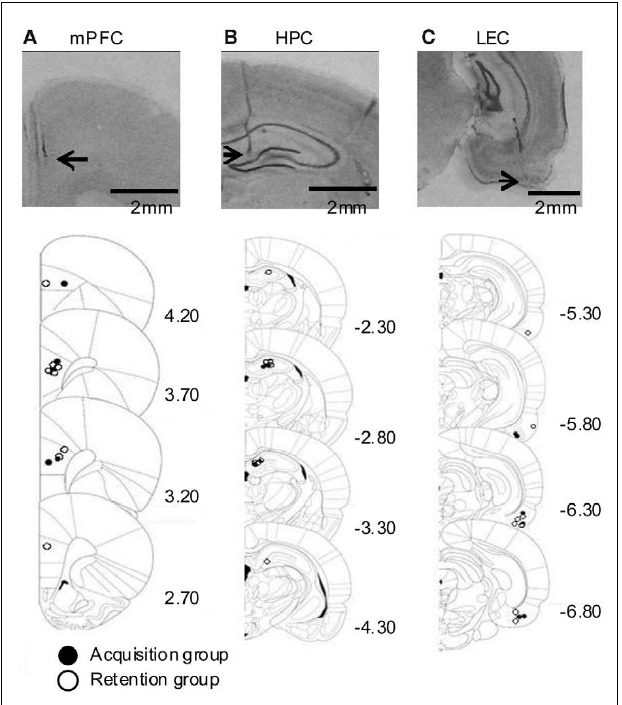
FIGURE 1 | Histological reconstruction of recording locations. (Top) Representative photomicrographs of coronal sections containing the medial prefrontal cortex [mPFC, (A) ], dorsal hippocampus [HPC, (B) ], and lateral entorhinal cortex [LEC, (C) ] from a rat. Arrows indicate the recording locations. (Bottom) Schematic illustration of the location of electrodes. Closed or empty circle indicates a placement in rats whose LFPs were recorded during acquisition sessions or during remote retention sessions, respectively. Numbers to the right indicate stereotaxic coordinates relative to bregma (Paxinos andWatson,